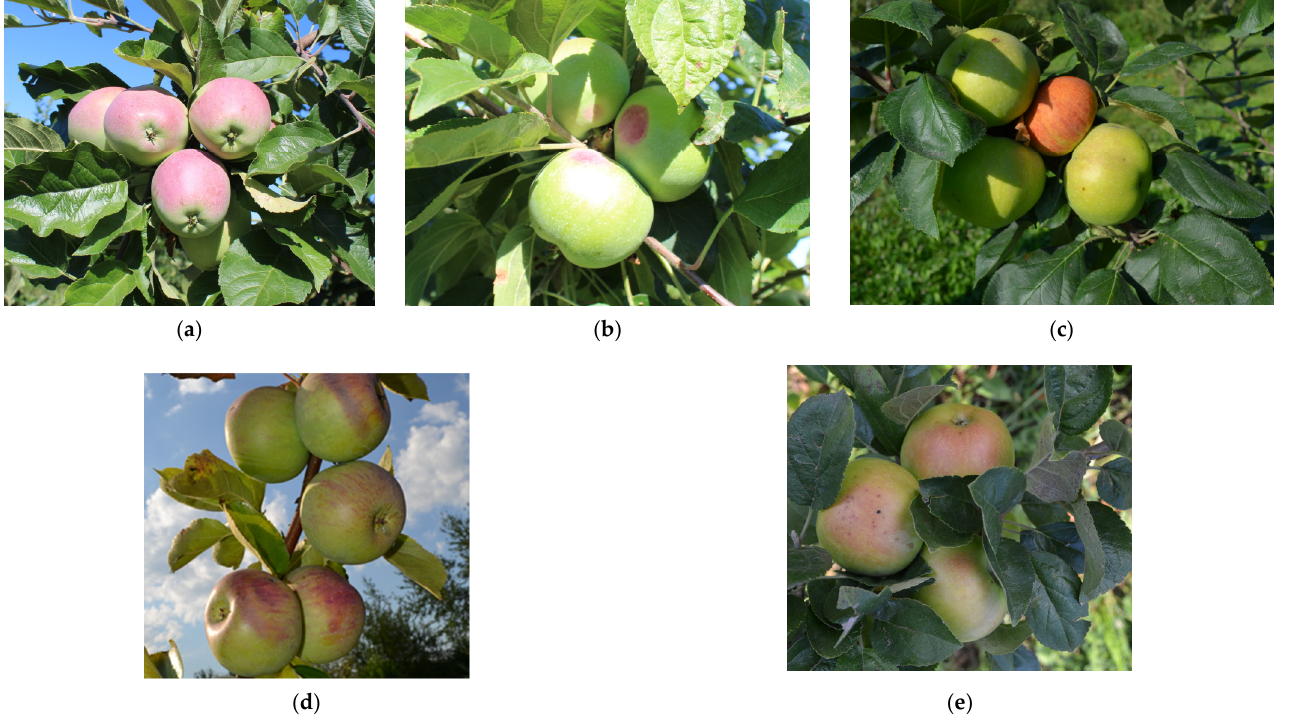
Figure 4. Commercial appearance of ( a ) ‘Botu Oii’, ( b ) ‘Jonathan de Munte‘, ( c ) ‘Mustoase’, ( d ) ‘Domnesc’ and ( e ) ‘Pătul’.